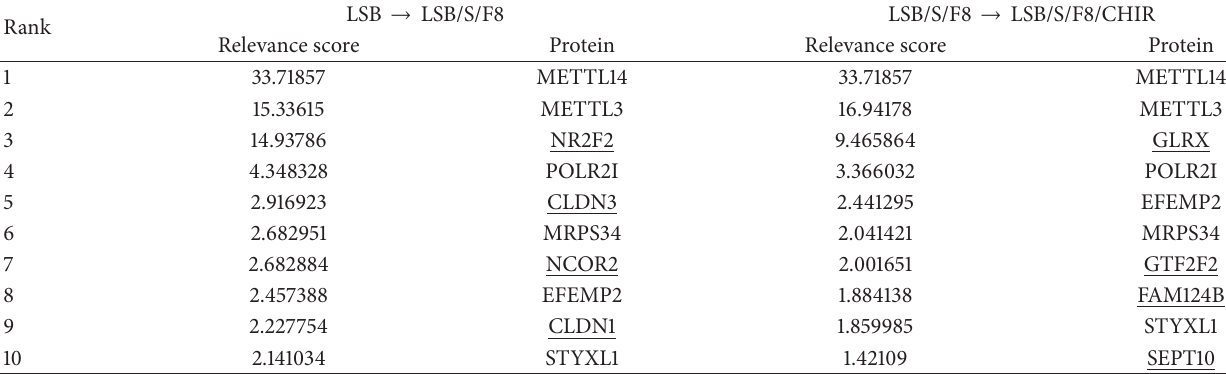
Table 1: The ten proteins with the highest relevance